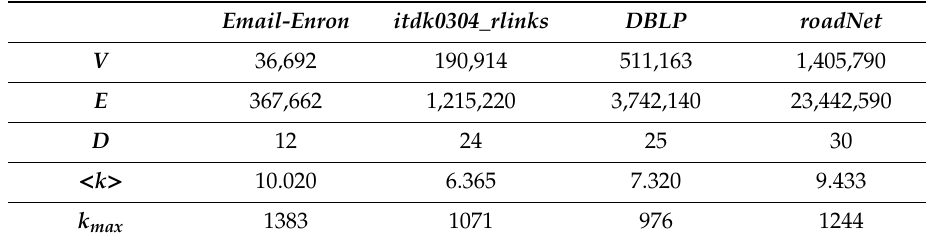
Table 1. Basic information of four networks.